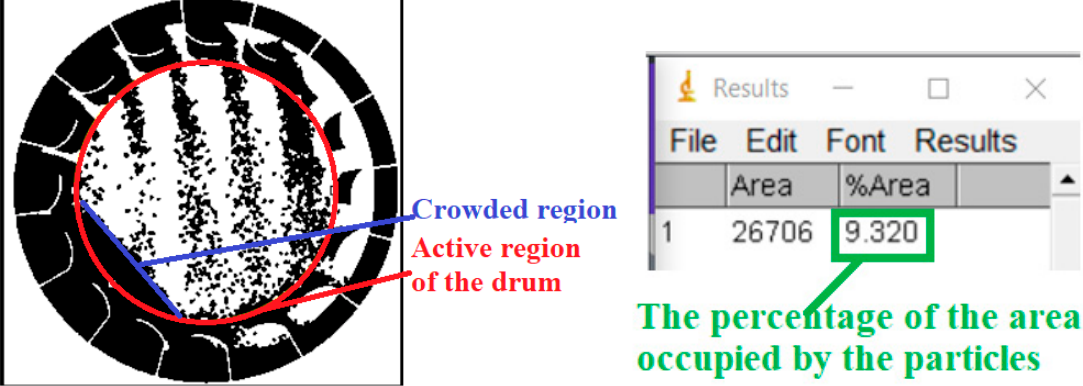
Figure 5. Determination of particle dispersion degree (ImageJ print screen). For better accuracy of the obtained results, using the recommendations from [28], the area occupied by the particles ( AOP ) was calculated after excluding thecrowded region (the agglomeration surfaces—Figure 5) from the bottom area of the